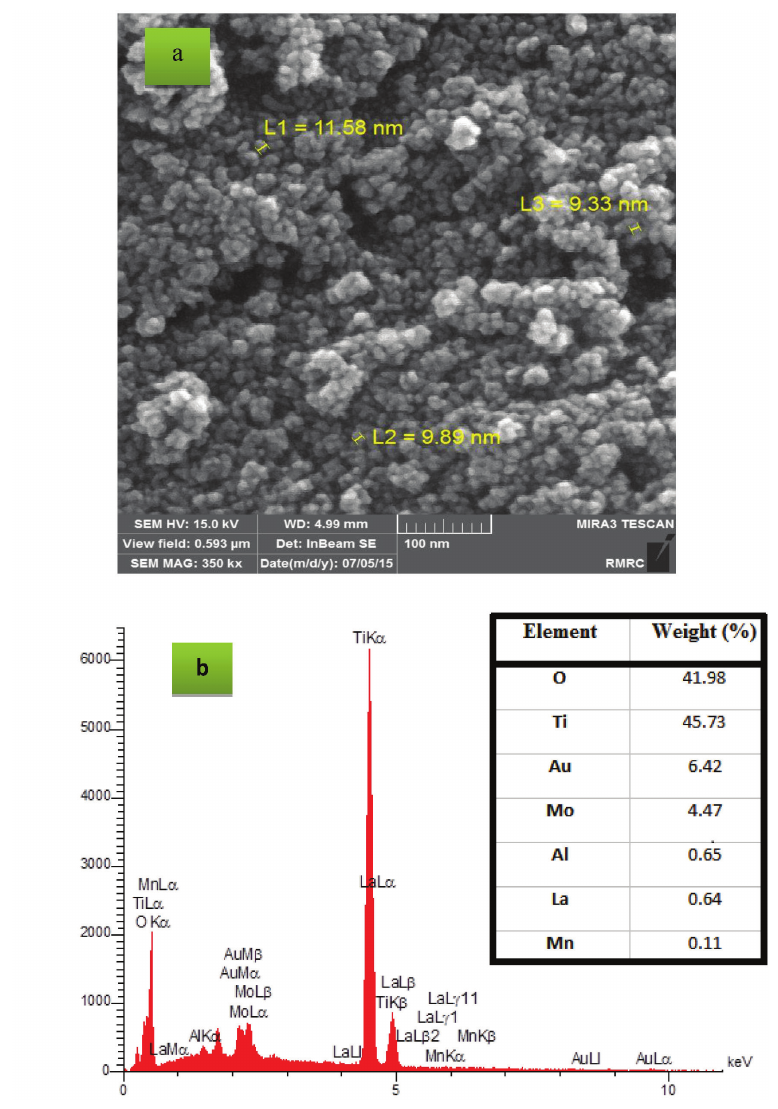
Fig. 4 – FE-SEM (a) and EDS (b) of Mn, Mo, la/Tio